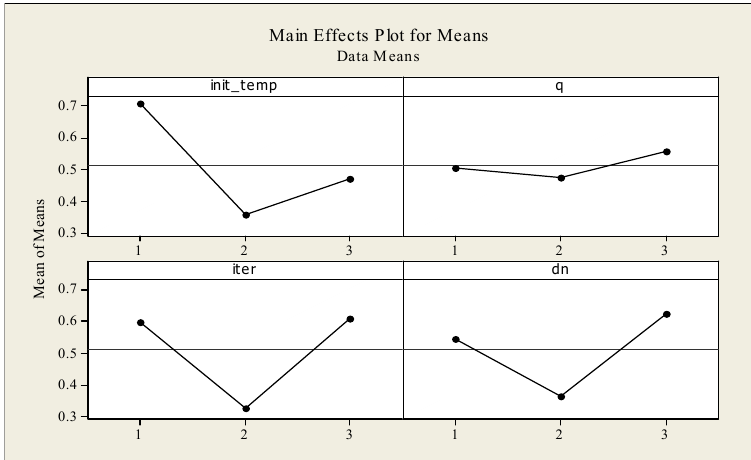
Fig. 4 determines the optimum level for each factor used the major effect diagram.